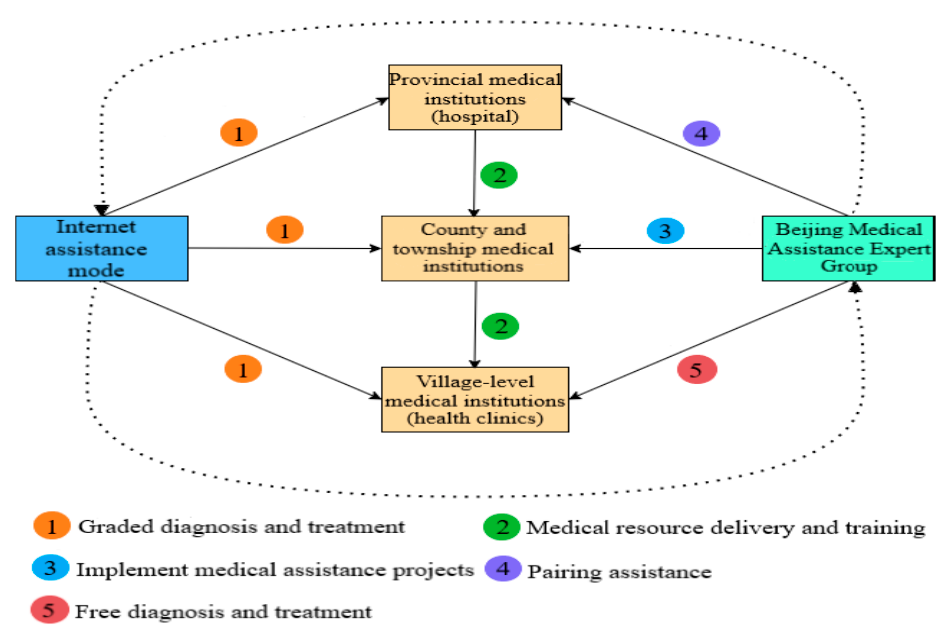
Figure 7. The detailed instructions of three-level diagnosis and treatment framework.